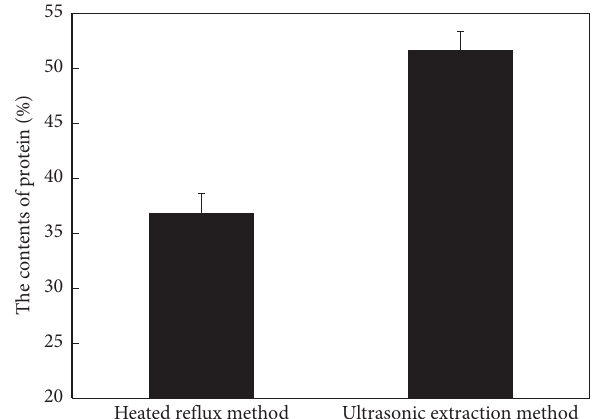
Figure 1: Efects of the extraction method on the contents of protein.